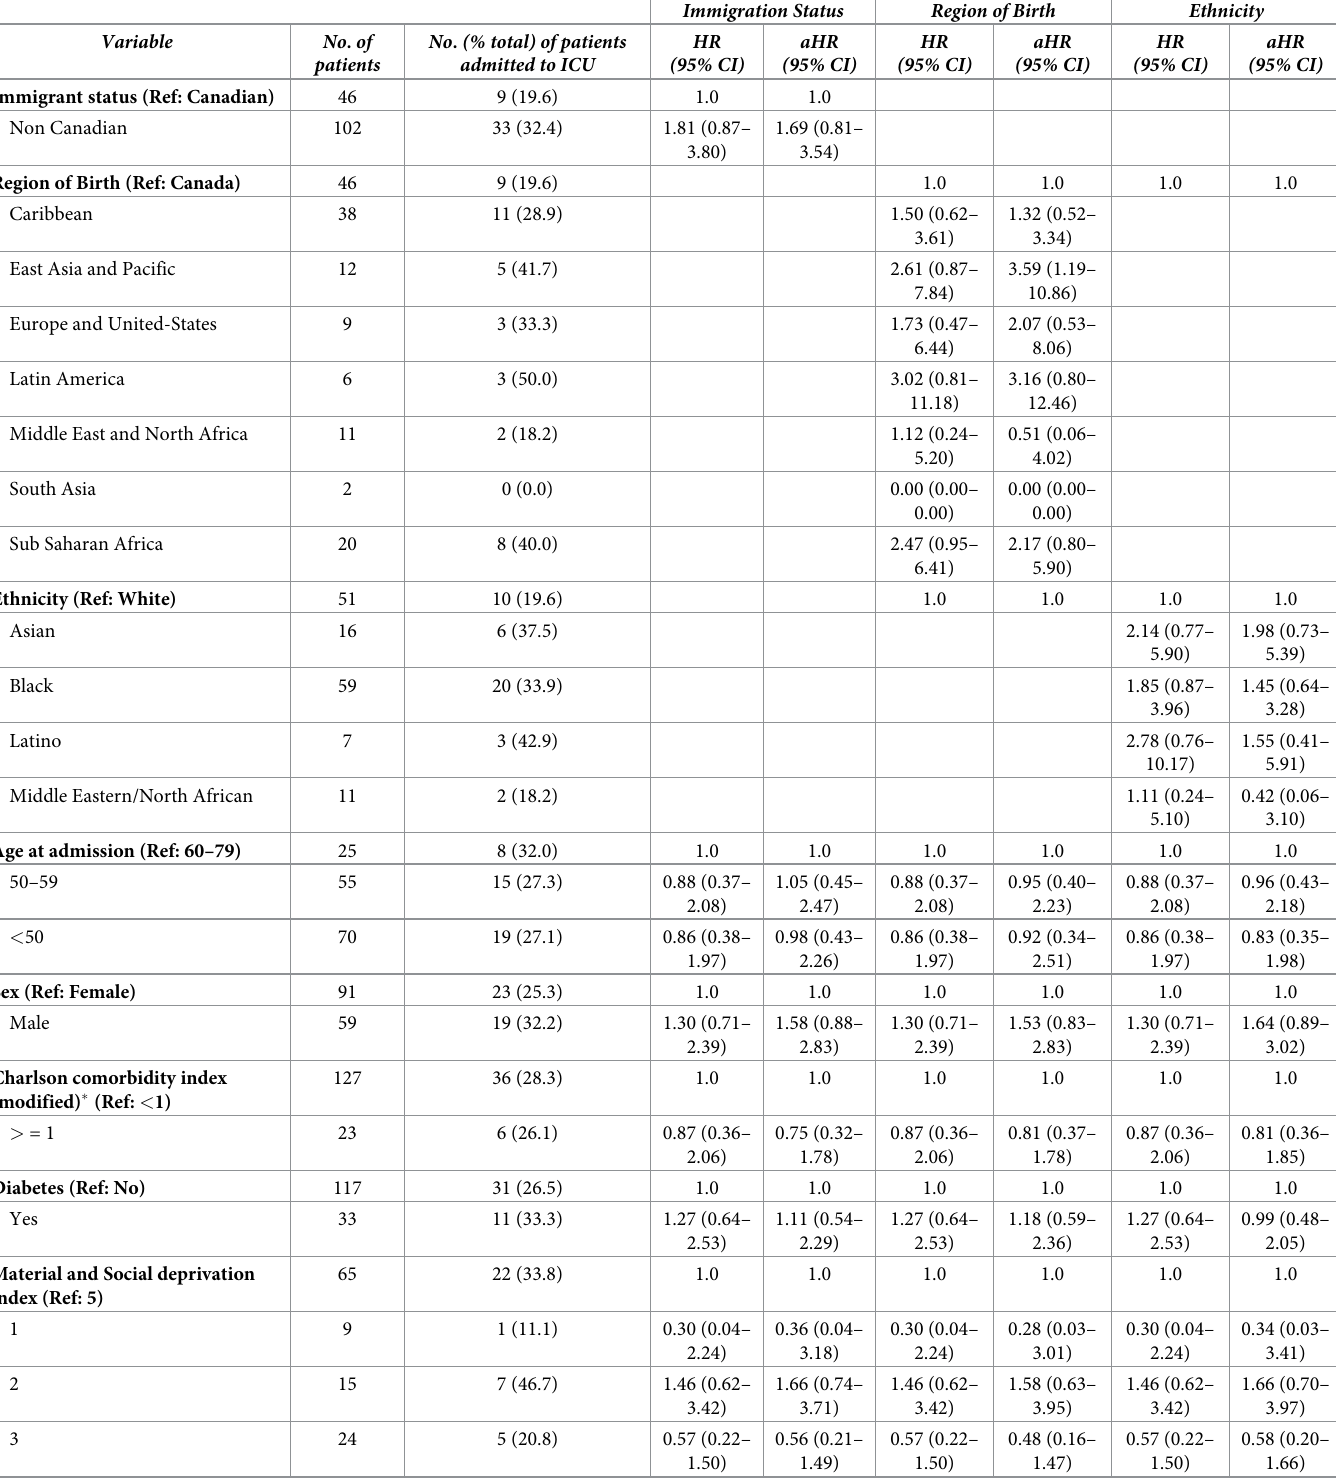
Table 3. Hazards of admission to the Intensive Care Unit among health care workers hospitalized with COVID–19 by immigrant status, region of birth and